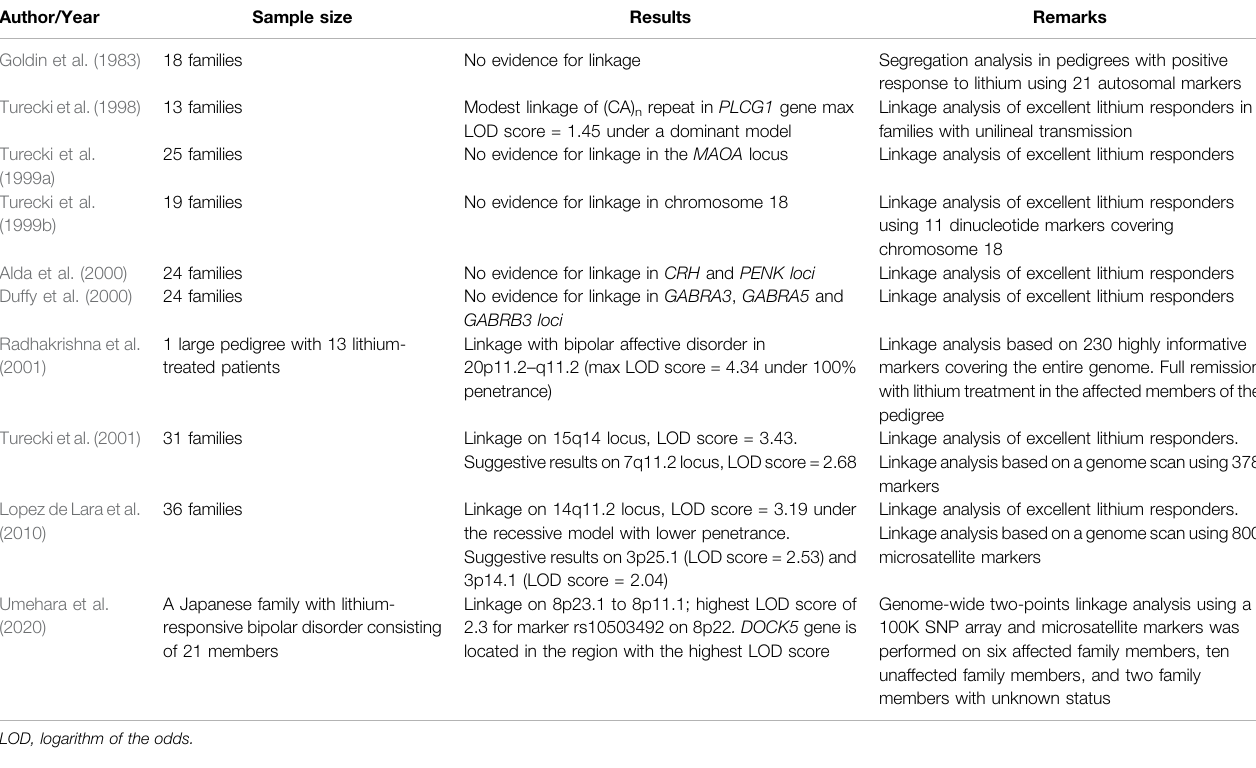
TABLE 1 | Linkage and segregation studies in lithium response.